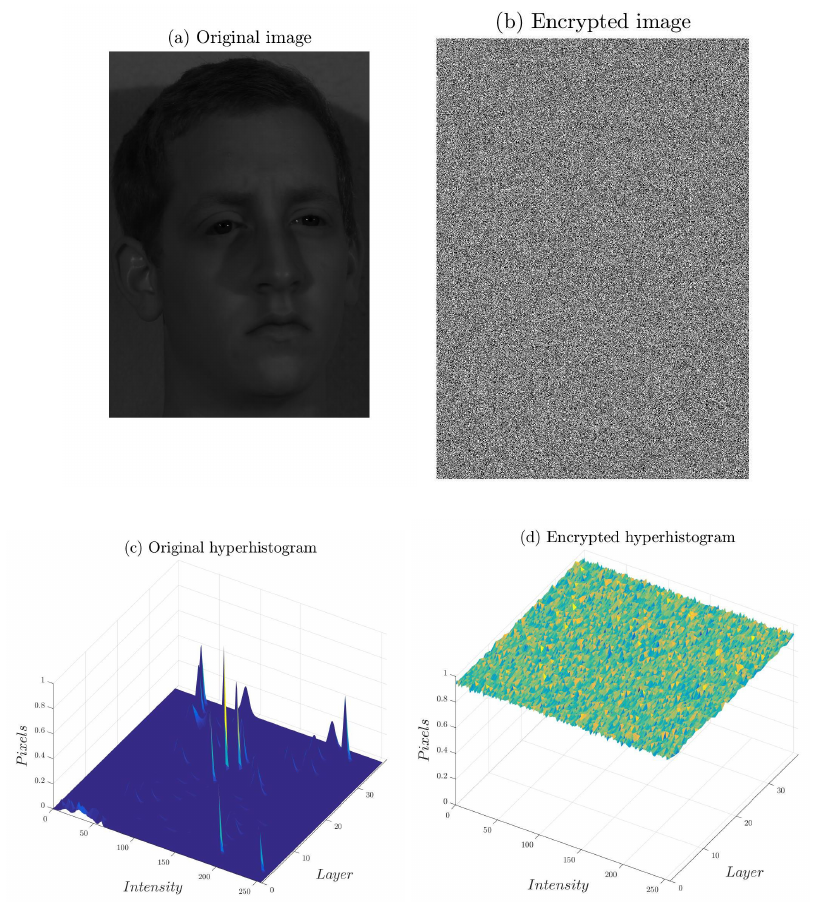
Figure 8. Original and encrypted image (layer one) of Male03